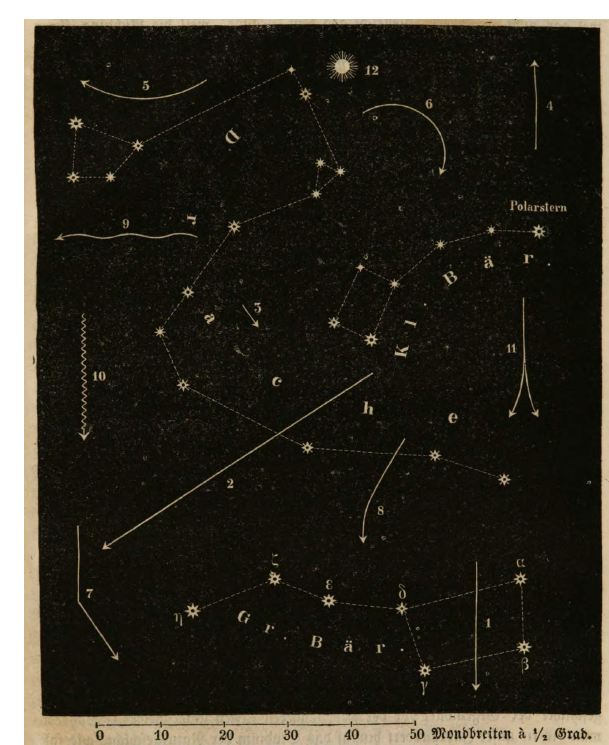
Figure 4. Different kinds of meteor trails (Heis, 1855a, p. 19).